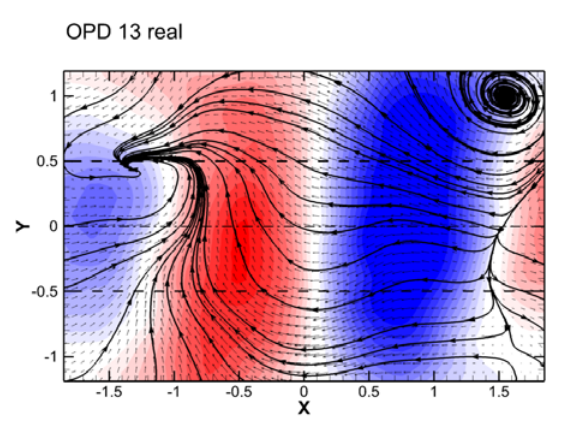
Fig. 10. Real part of the OPD mode 13 topology .